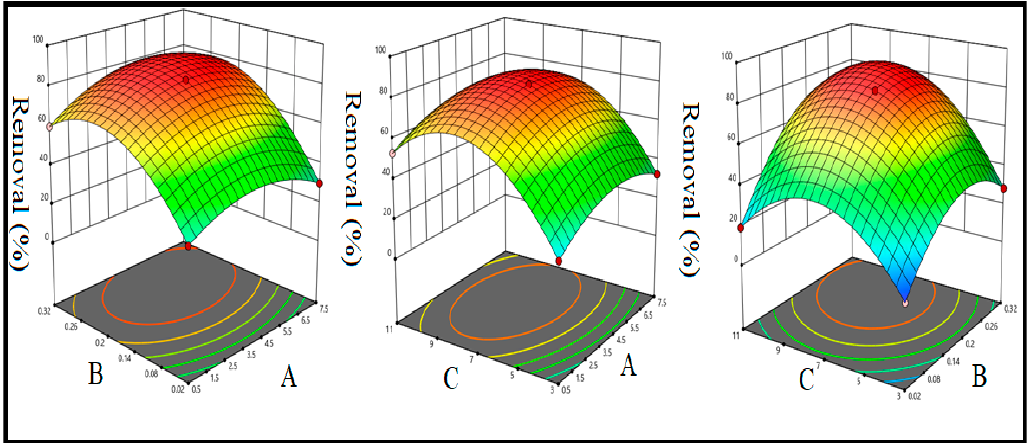
Figure 6. Response surface plots for the combined effects of ( A ) contact time and pH; ( B ) contact time and adsorbent dose; ( C ) pH and adsorbent dose on the % removal of citalopram.